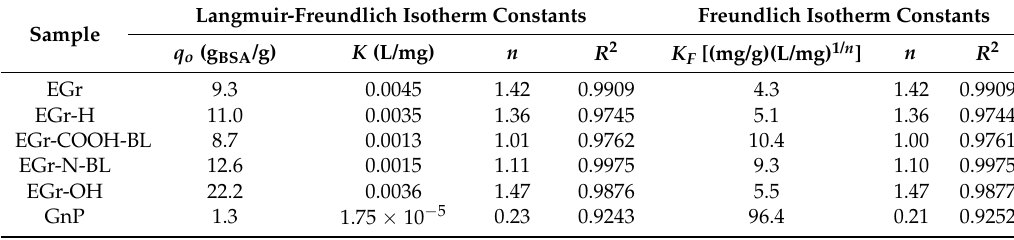
Table 4. Fitting parameters of BSA adsorption isotherms to Langmuir-Freundlich and Freundlich equations. The allowable error of the fitting parameters was 1%. q o is the maximum adsorption of BSA per gram of the adsorbent, K is the equilibrium constant, n represents the heterogeneity of the site energies and R 2 is regression